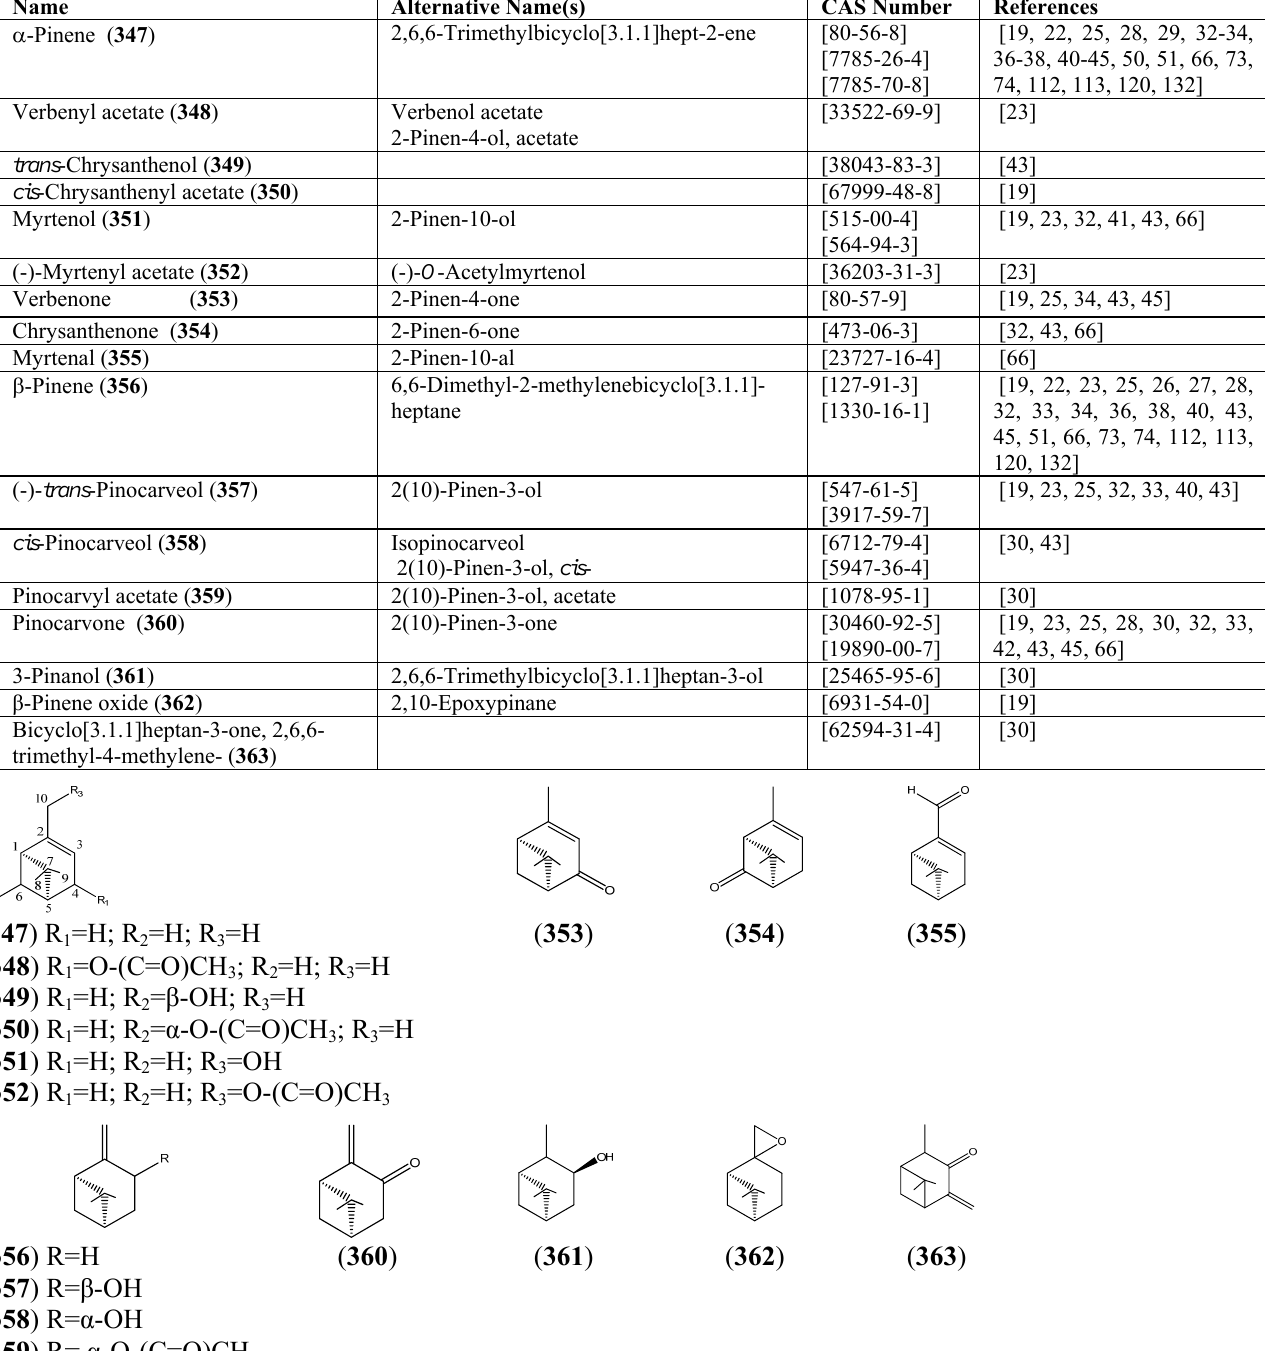
Table 27. Pinane Monoterpenoids (2,6,6-Trimethylbicyclo[3.1.1]heptane,